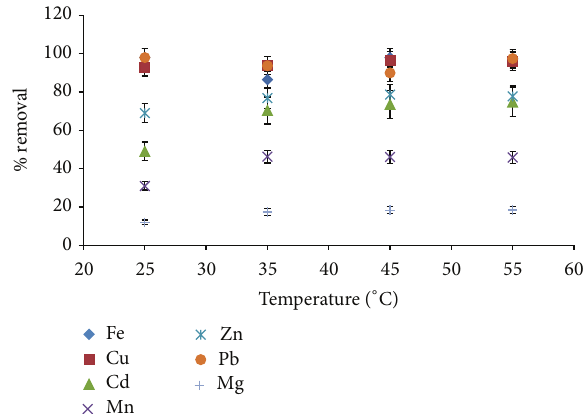
Figure 12: Effect of particle size on metal removal using MNS.